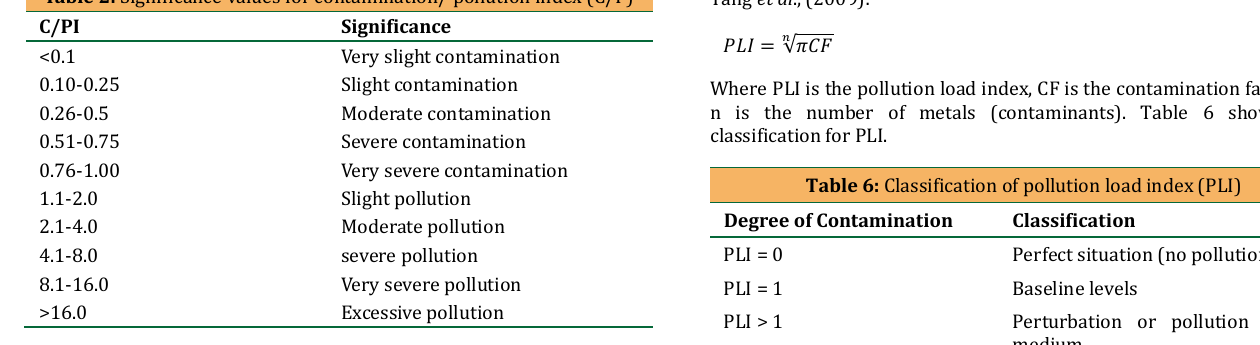
Table 2: Significance values for contamination/ pollution index (C/P)